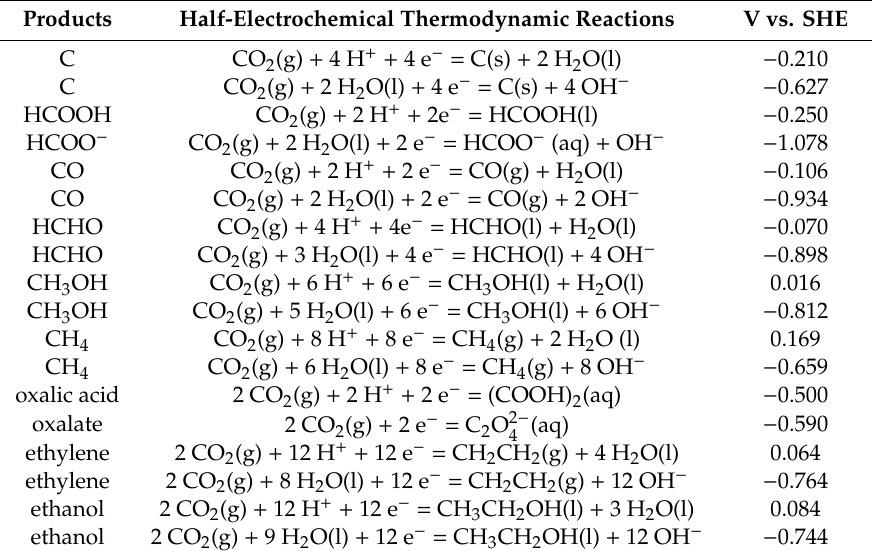
Table 5. CO 2 reduction potentials vs. SHE a .